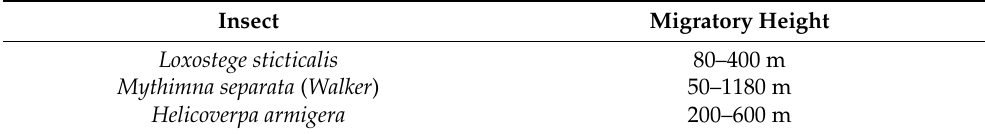
Table 1. Migration height of typical